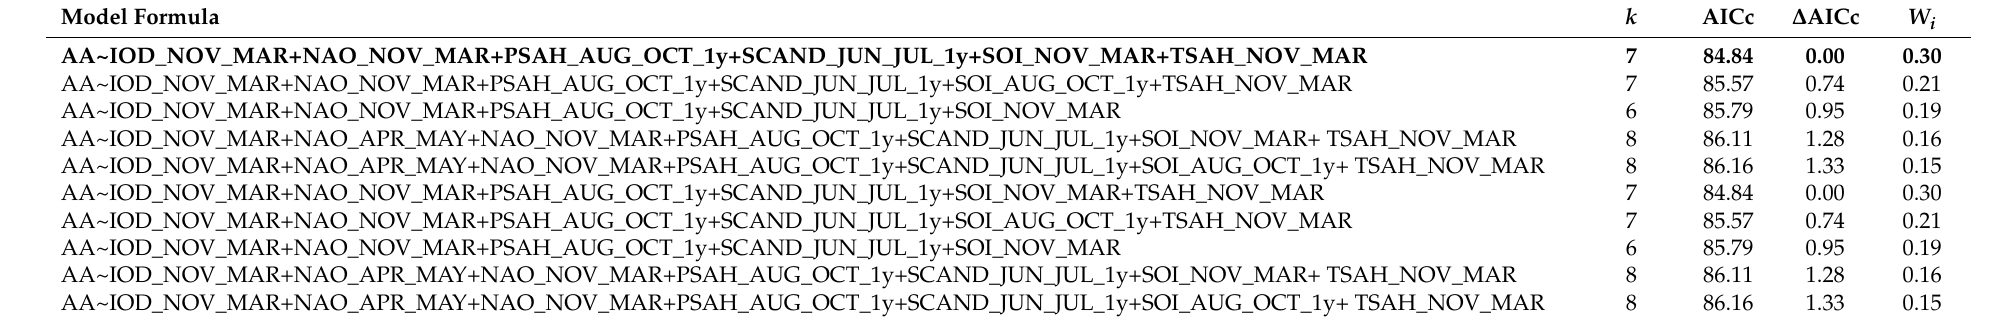
Table A22. Model selection procedure by “all subsets”, according to AICc, from the full model of the relationship between the 15 climate variables and the year, and the overall timing of migration as measured by Annual Anomaly (AA) for the Common Redstart Phoenicurus phoenicurus caught at Bukowo, Poland, in 1982–2017. Symbols as in Table A19. The best model, discussed in the text, in bold face.